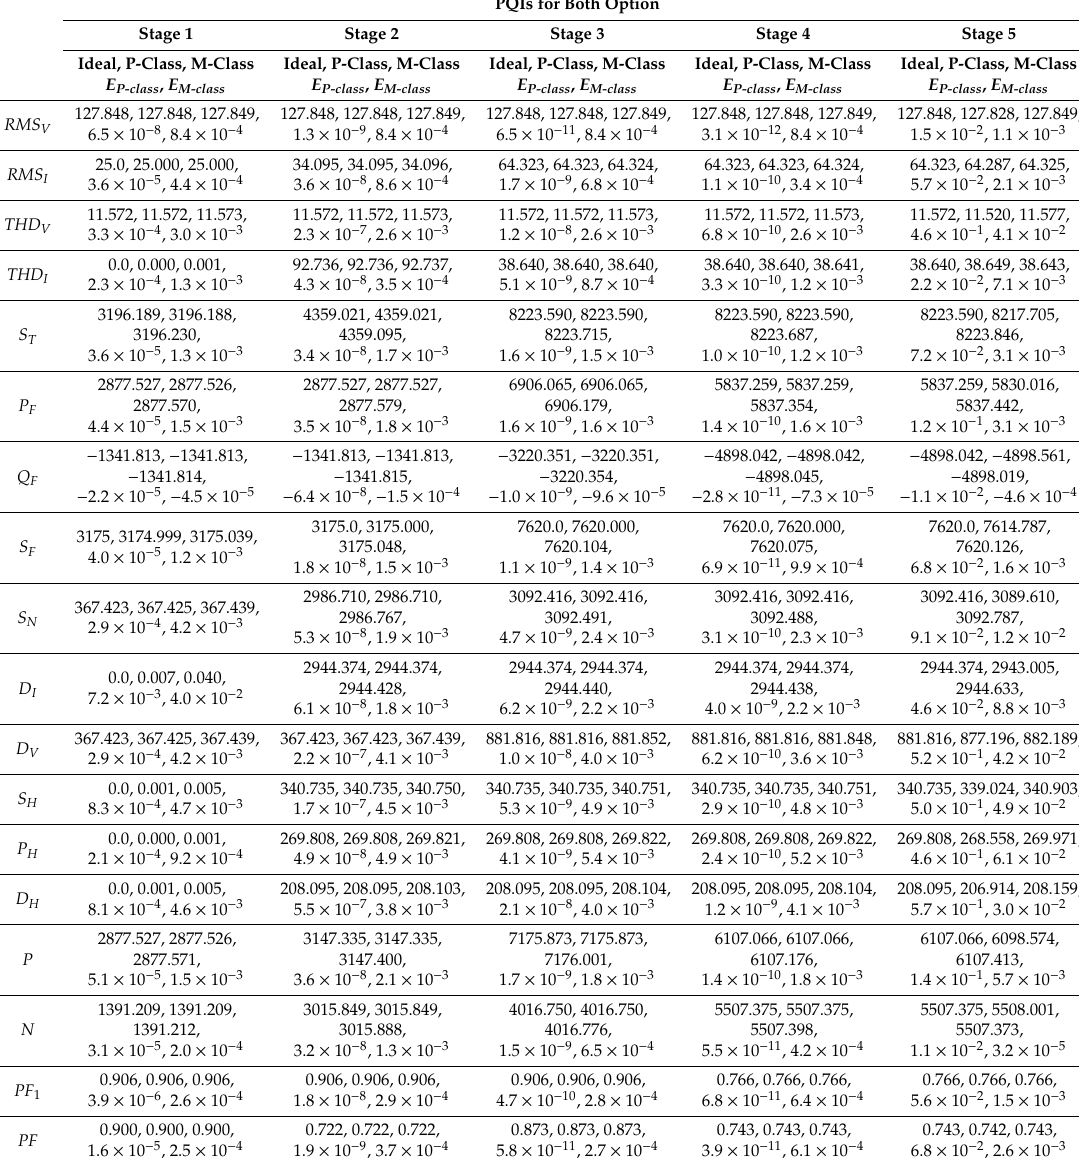
Table A2. Numerical results of PQIs for synthetic